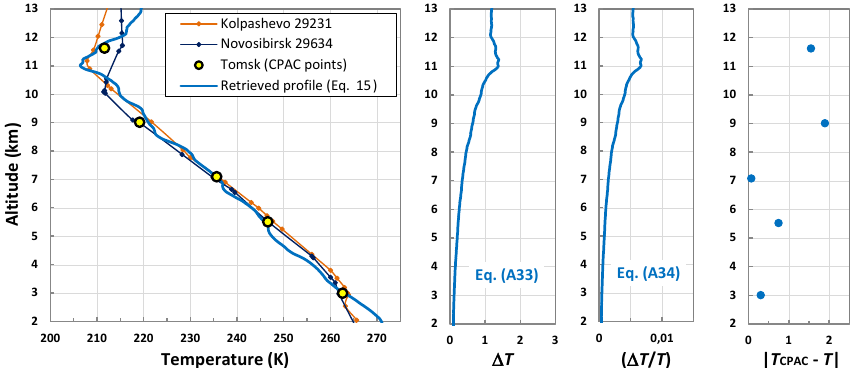
Figure 7. (1 April 2015) Temperature profile retrieved using the temperature retrieval function (Eq. 15) derived from the calibration function suggested by Gerasimov and Zuev (2016). The uncertainties (cid:49) T and ( (cid:49) T / T ) are calculated by Eqs. (A33) and (A34), respectively.